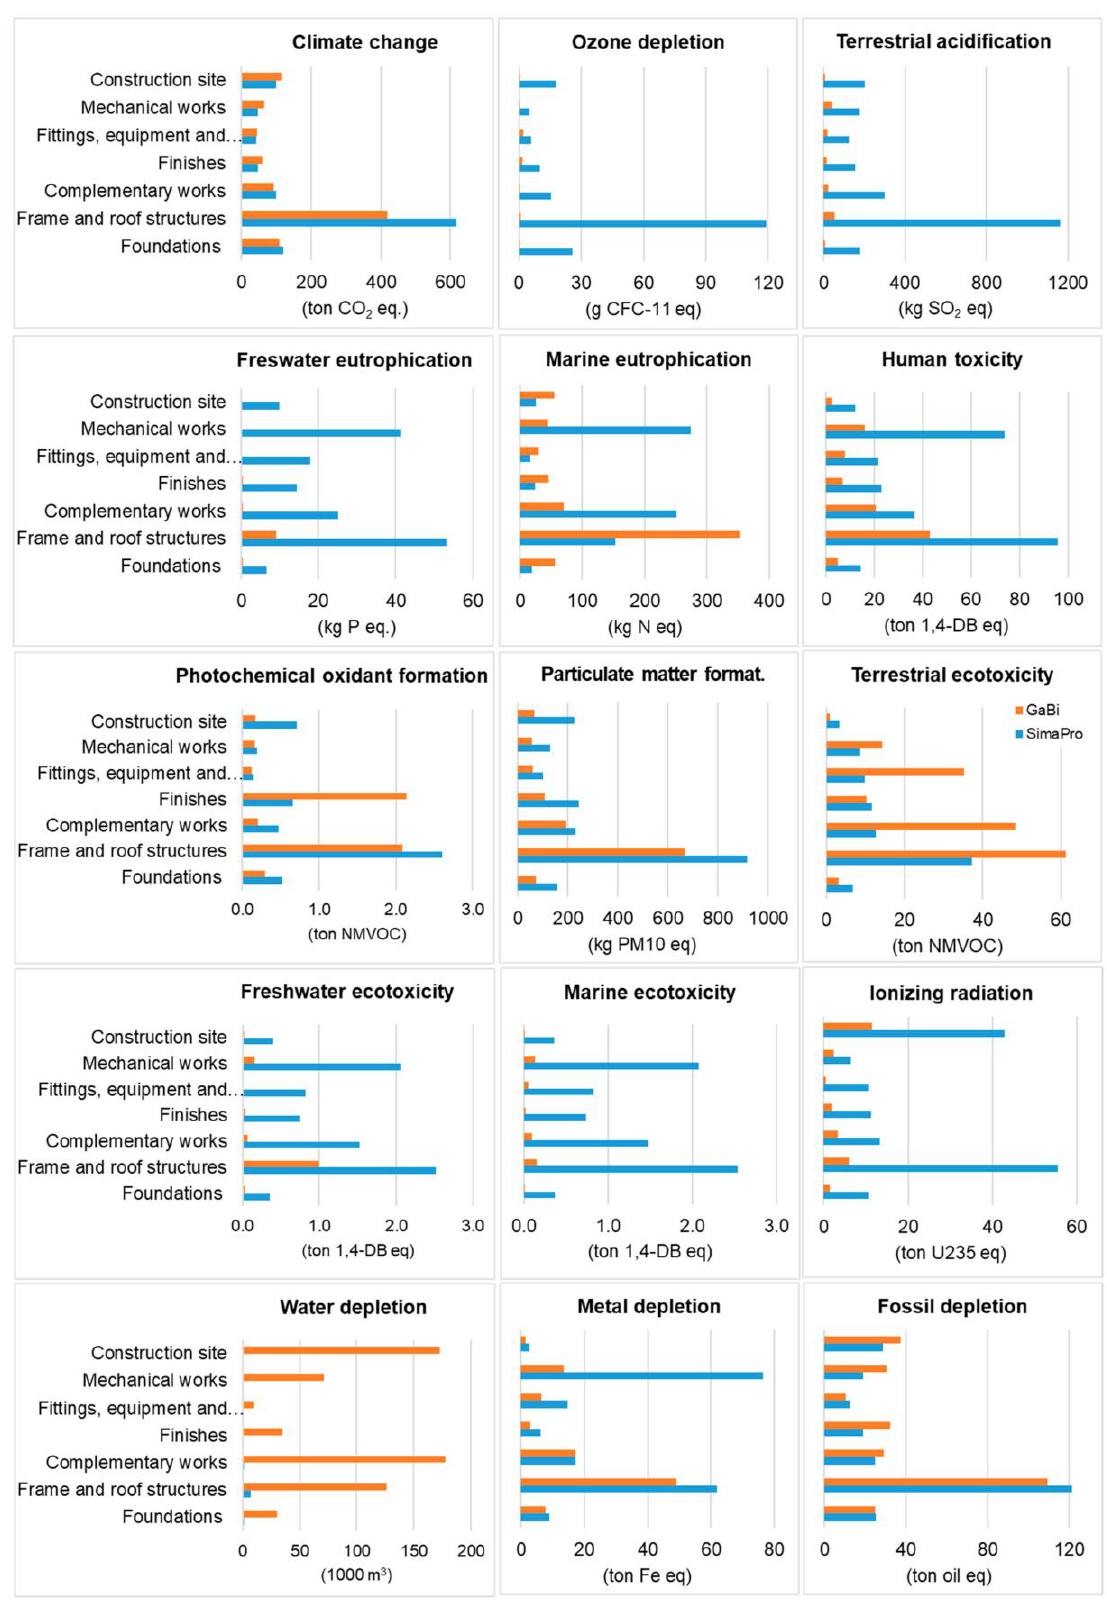
Figure 3. Breakdowns of 15 environmental impacts of KÄPYLÄ by building system.